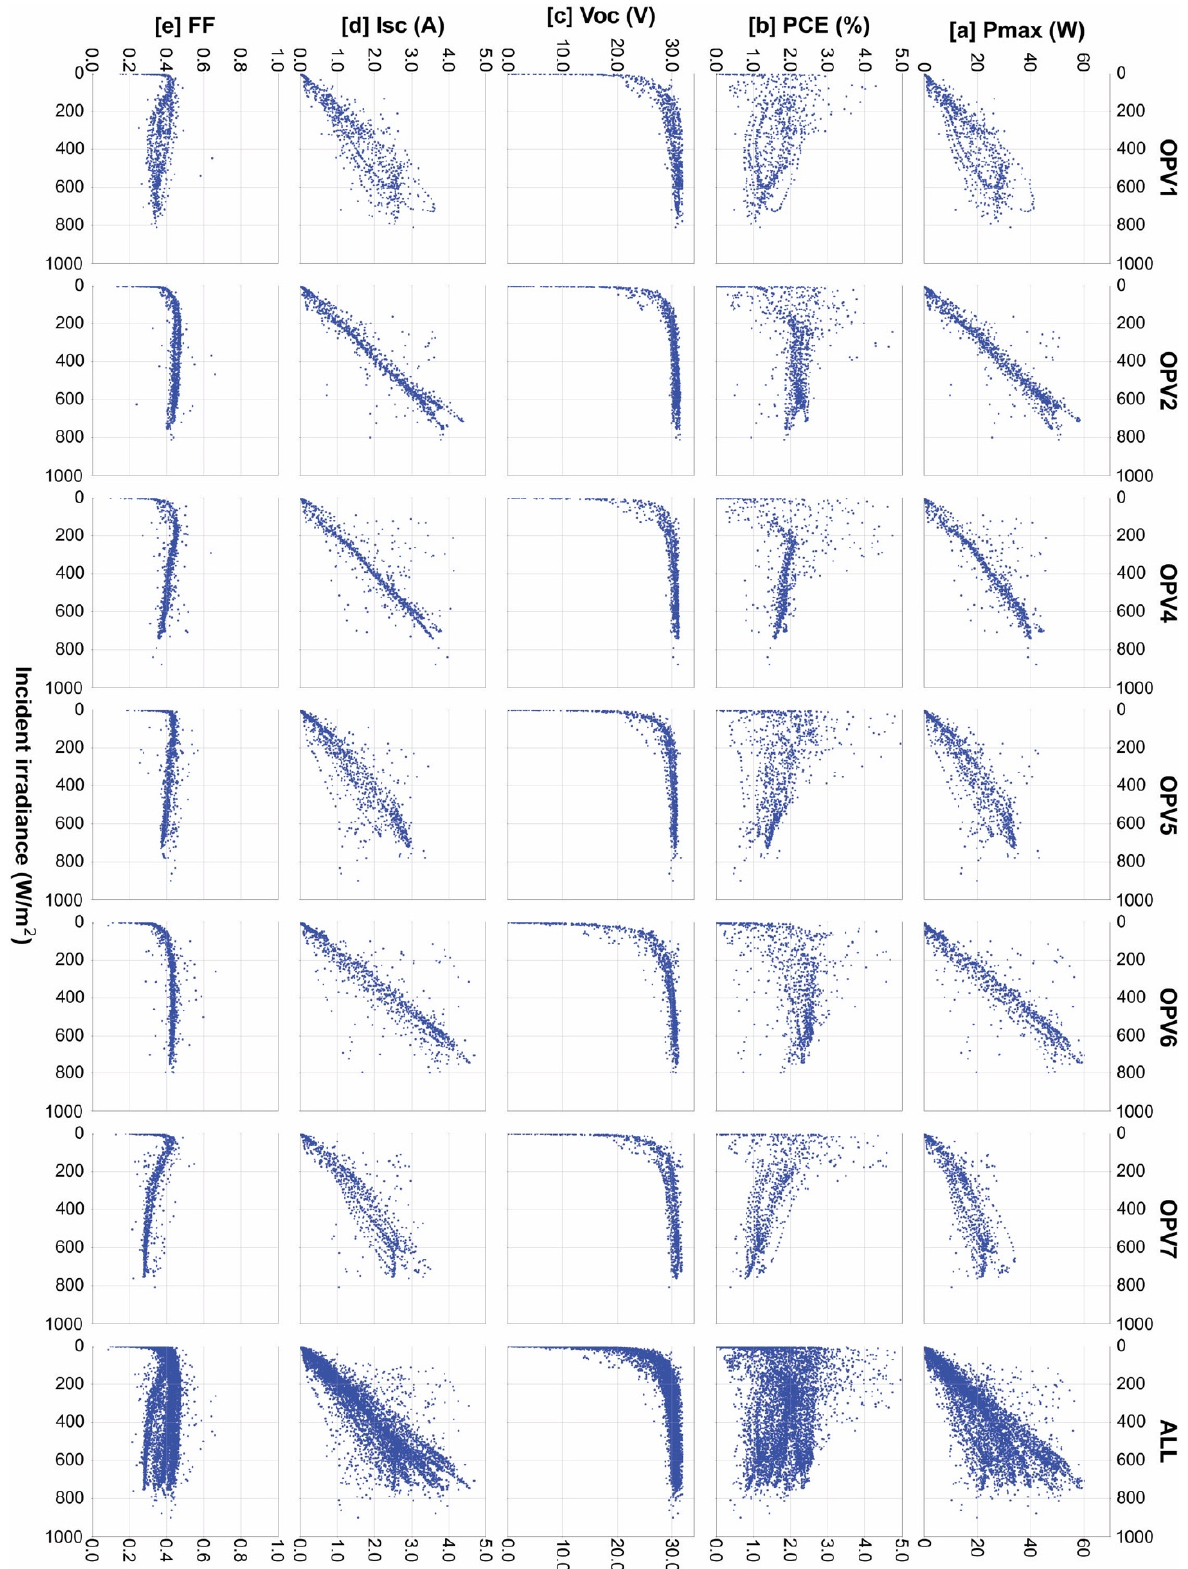
Figure 9. Effect of incident irradiance on OPV array performances between 28 October 2019–19 February 2020. Each point corresponds to a single I-V curve measurement of the connected OPV roll.